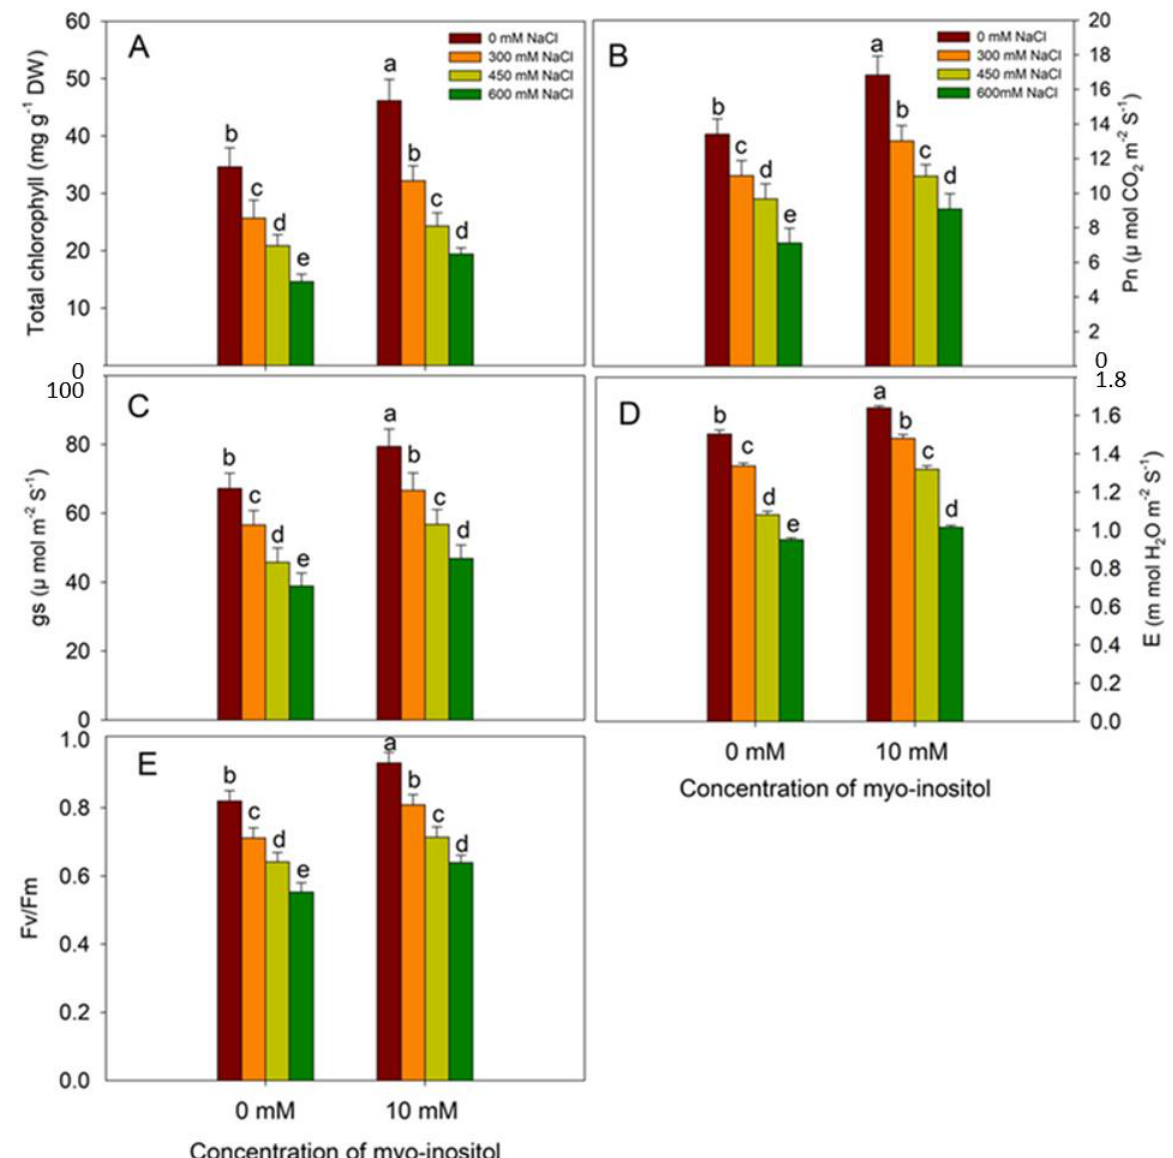
Figure 2. Effect of different salinity (300, 450, and 600 mM NaCl) concentrations with and without exogenous application of myo-inositol (10 mM) on changes in photosynthetic attributes and gas exchange in Quinoa ( Chenopodium quinoa L. var. Giza1). Data expressed as ( A ) total chlorophyll content (Chl); ( B ) net photosynthetic rate ( Pn ); ( C ) stomatal conductance (gs); ( D ) transpiration rate, and ( E ) photosynthetic efficiency ( Fv/Fm ). Values are mean ( ± SE) of four replicates, and different letters represent significant differences at p ≤ 0.05.